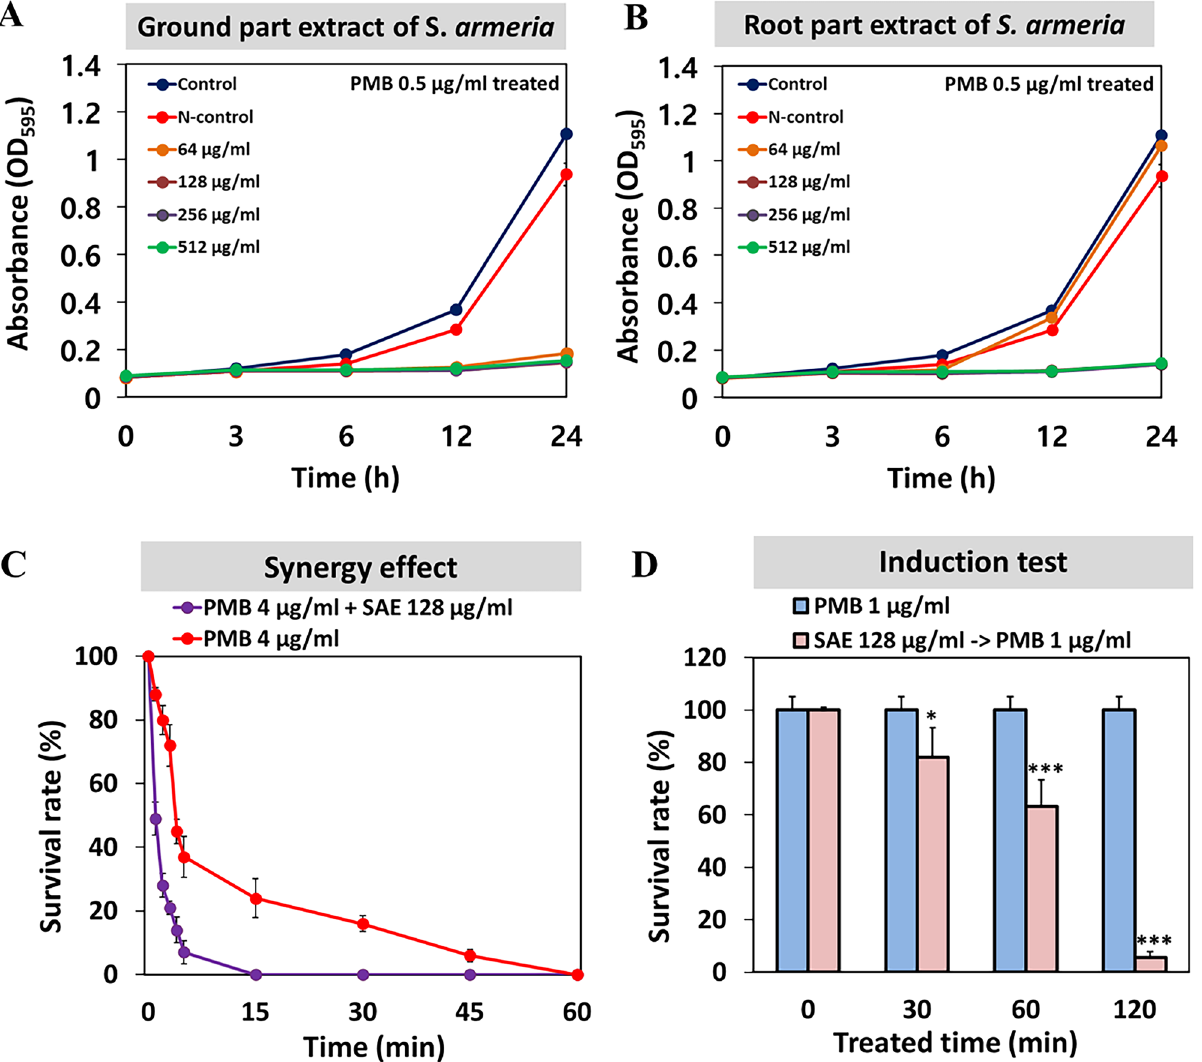
Figure 1. Growth and killing assay of A. baumannii treated with PMB and S. armeria extract. ( A ) Synergistic effect with ground part extract of S. armeria . The concentration of PMB used in the experiment was fixed at 0.5 μg/mL. The same volume of DMSO was used as the positive control. ( B ) Synergistic effect with root part extract of S. armeria . ( C ) Bactericidal effect on A. baumannii cells treated with only PMB or with a combination of PMB and SAE. ( D ) PMB susceptibility testing by exposure time to SAE. Exposure to SAE (128 μg/mL) for 0, 30, 60, and 120 min was followed by treatment with PMB (1 μg/mL). Statistical analysis was performed using Student’s t-test (* P < 0.05, *** P <